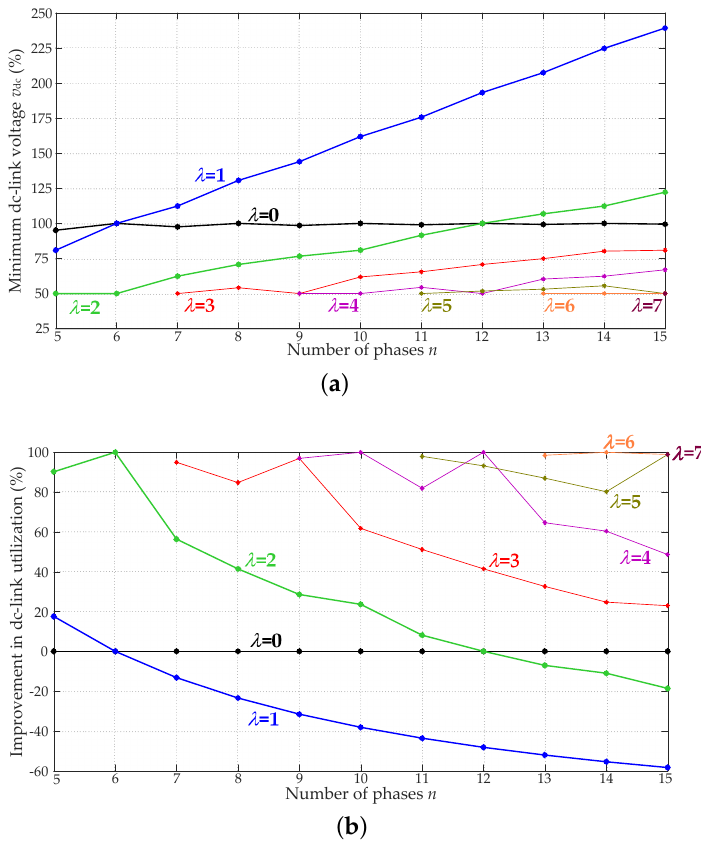
Figure 35. Comparison of dc-link utilization depending on the type of stator phase connection λ and the phase number n . ( a ) Expressed as minimum dc-link voltage required for ensuring operation in the linear modulation range, normalized by twice the magnitude of the back-EMF [344]. ( b ) Expressed as improvement with respect to star ( λ =